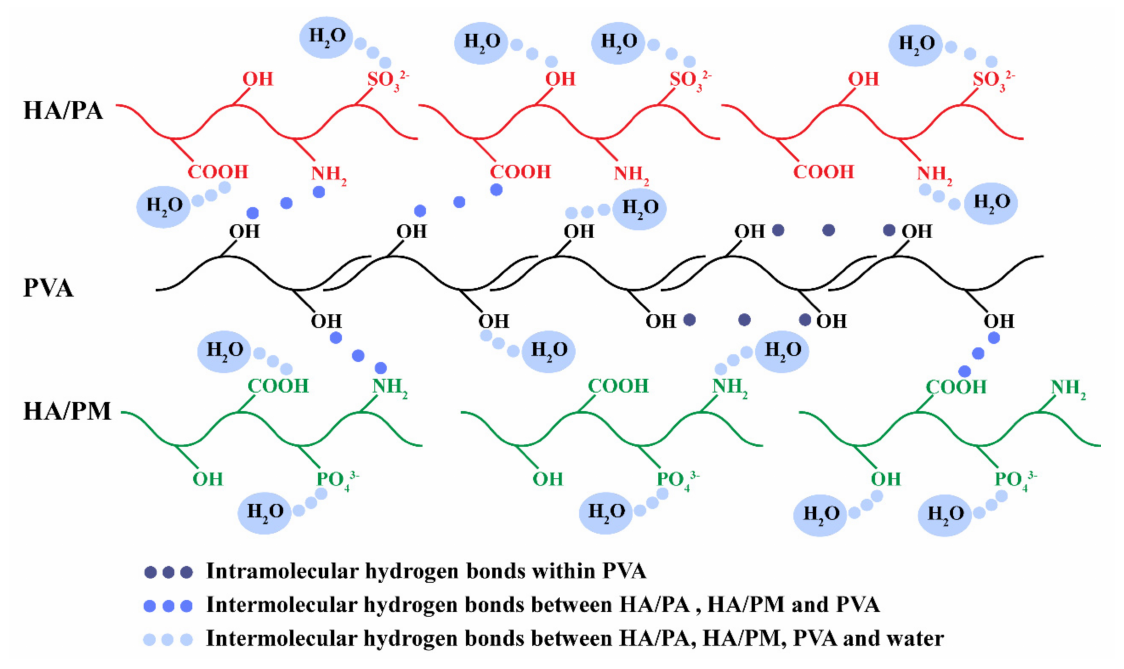
Figure 3. Schematic illustration of the formation and interactions of hydrogen bonds in the HPX/PVA hydrogels. Intramolecular hydrogen bonds were formed within PVA (–OH). Intermolecular hydrogen bonds were formed between HA/PA, HA/PM (–NH 2 or –COOH), and PVA (–OH).